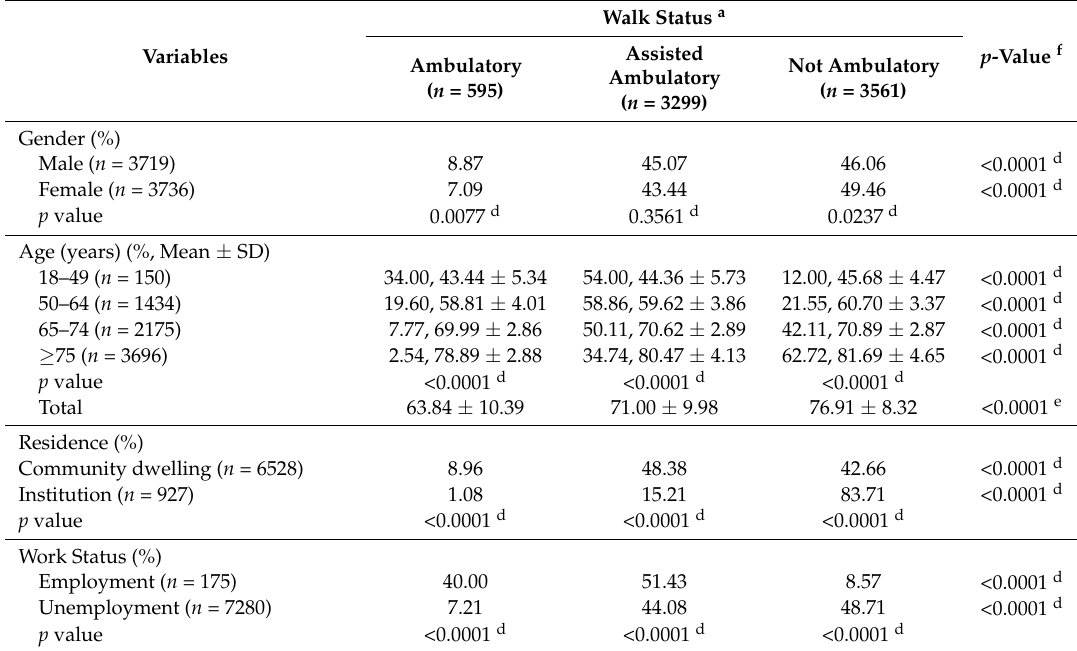
Table 2. Demographic table by Walk Status, n =